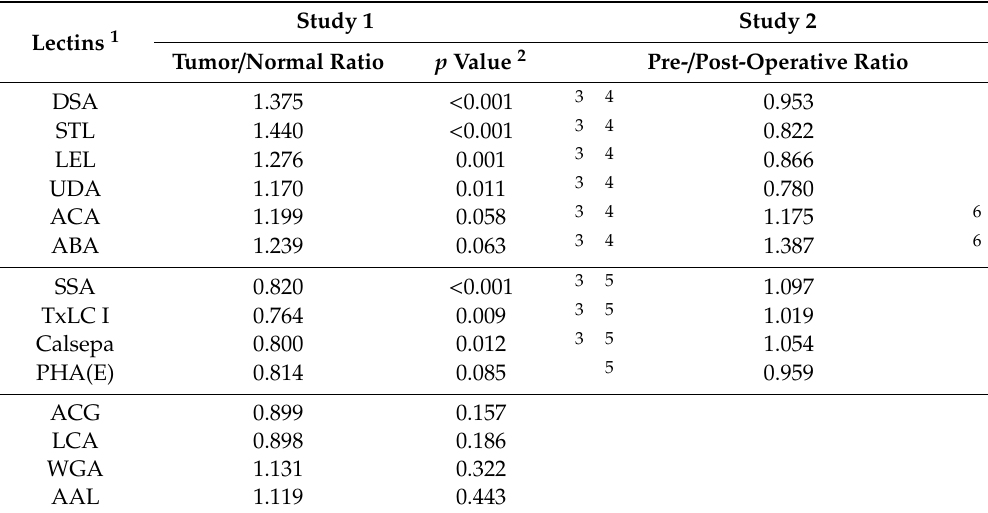
Table 1. List of lectins with Altered Signal in PC Sera by lectin Microarray Analysis. Study 1 Study Lectins 1